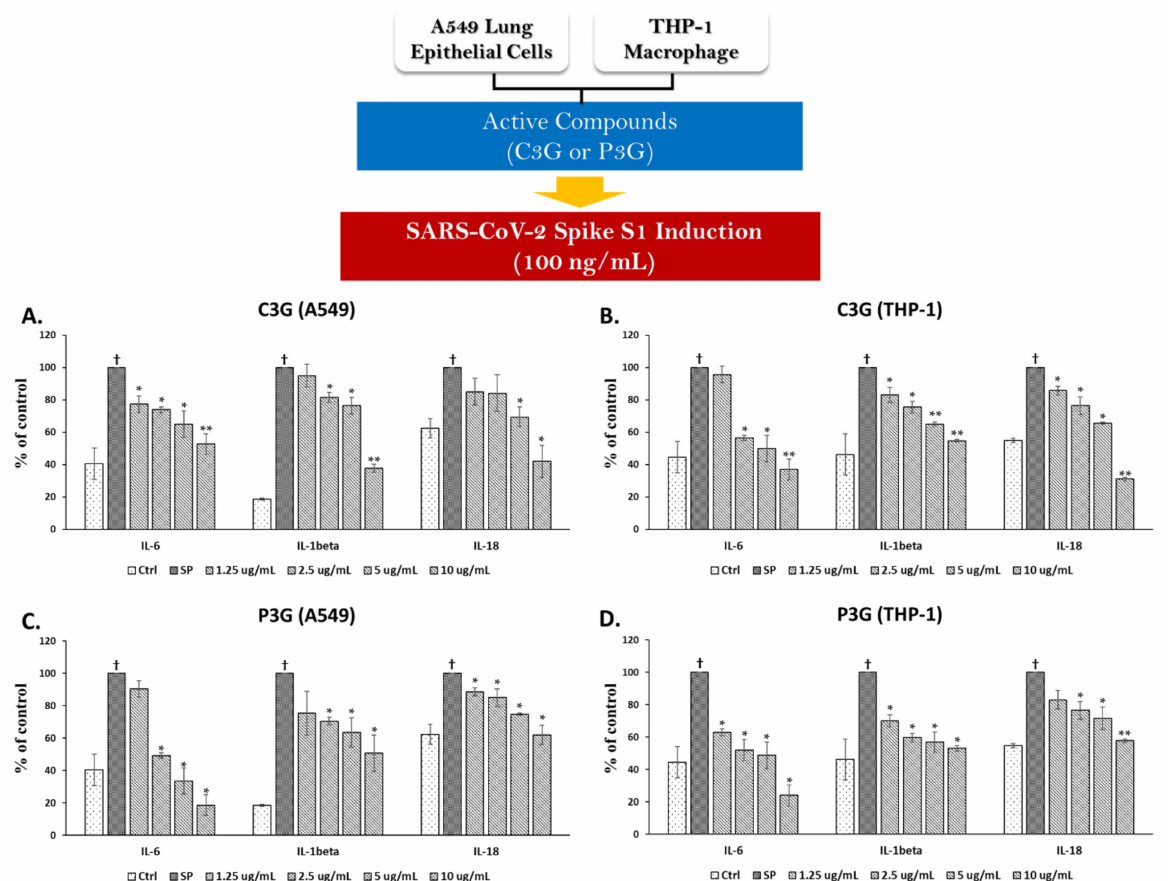
Figure 6. Cyanidin-3-O-glucoside (C3G) and peonidin-3-o-glucoside (P3G) ameliorated the SP- induced inflammation in A549 lung cells and THP-1 macrophages by inhibiting the cytokine secre- tions. A549 (at 3 × 10 5 cell/well) and PMA-treated THP-1 macrophage (6.5 × 10 5 cell/well) were pre-treated with the active compounds at the concentration of 0–10 µ g/mL for 4 h, and then chal- lenged with 100 ng/mL of SP for 3 h, then the supernatant was collected. The inhibitory effect of C3G ( A , B ) and P3G ( C , D ) on SP-induced inflammatory cytokine secretions (IL-6, IL1 β , and IL-18) in A549 cells and in THP-1 macrophages were determined using ELISA. Data are presented as mean ± S.D. values of at least three independent experiments. * p < 0.05, ** p < 0.01 vs. SP-induced control group. † p < 0.05 vs. non-treated control